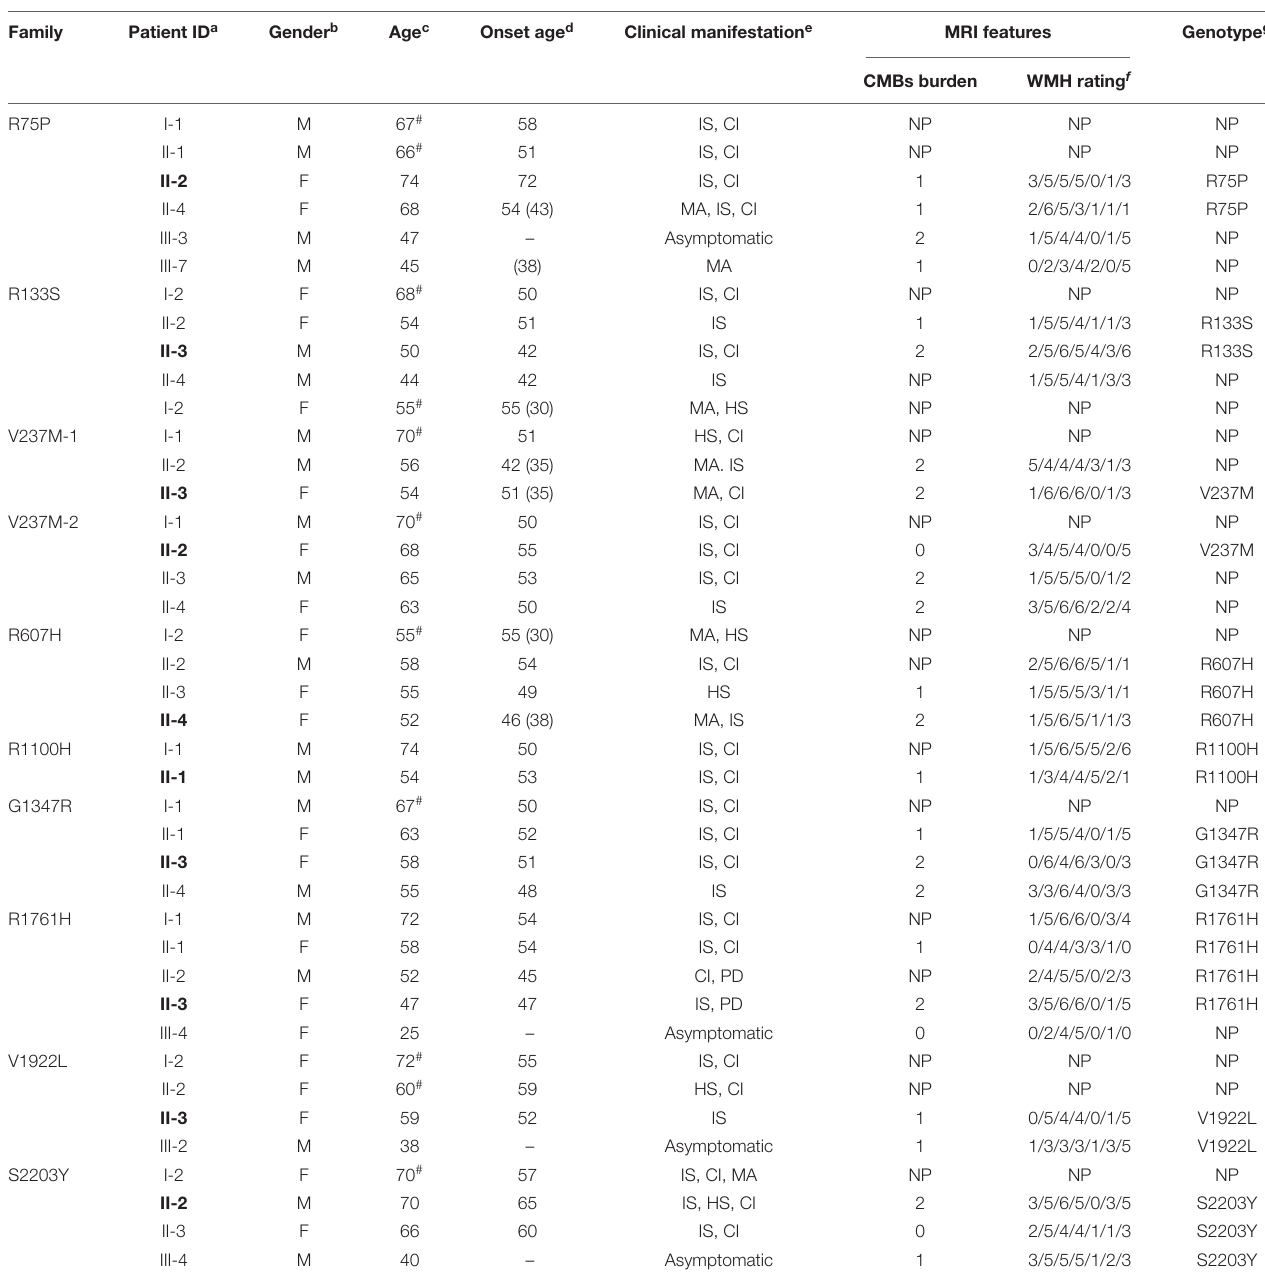
TABLE 3 | Clinical features of probands and affected family members carrying untypical NOTCH3